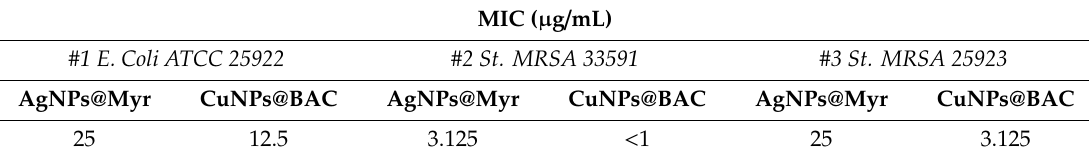
Table 5. Minimum inhibitory concentrations (MICs) of tested myramistin-capped silver nanoparticles (AgNPs) and CuNPs samples against three microorganisms strains. MIC ( µ g / mL) #1 E. Coli ATCC